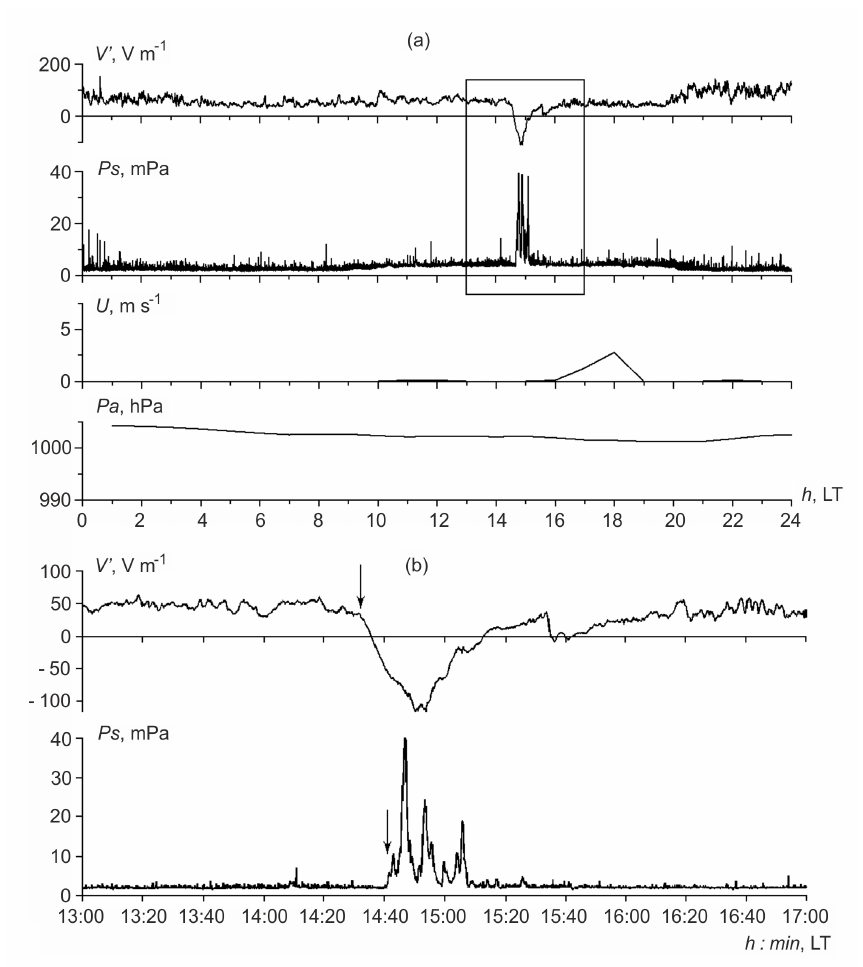
Figure 4. Record fragment of atmospheric electric field potential gradient V (cid:48) , acoustic pressure P s , wind velocity U and air pressure P a on 22 August 2006 ( a ) and a developed view of the record selected interval ( b ). Arrows indicate the beginning of V (cid:48) and P s